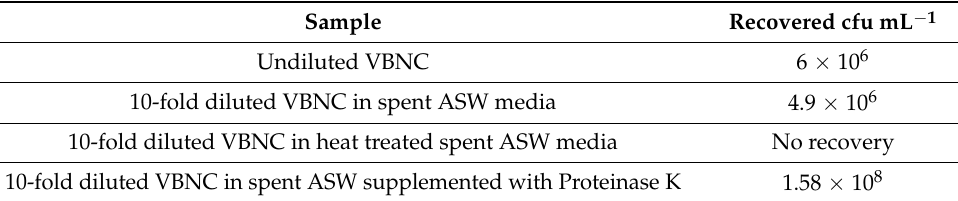
Table 1. Resuscitation-promoting ability of VBNC cells in different